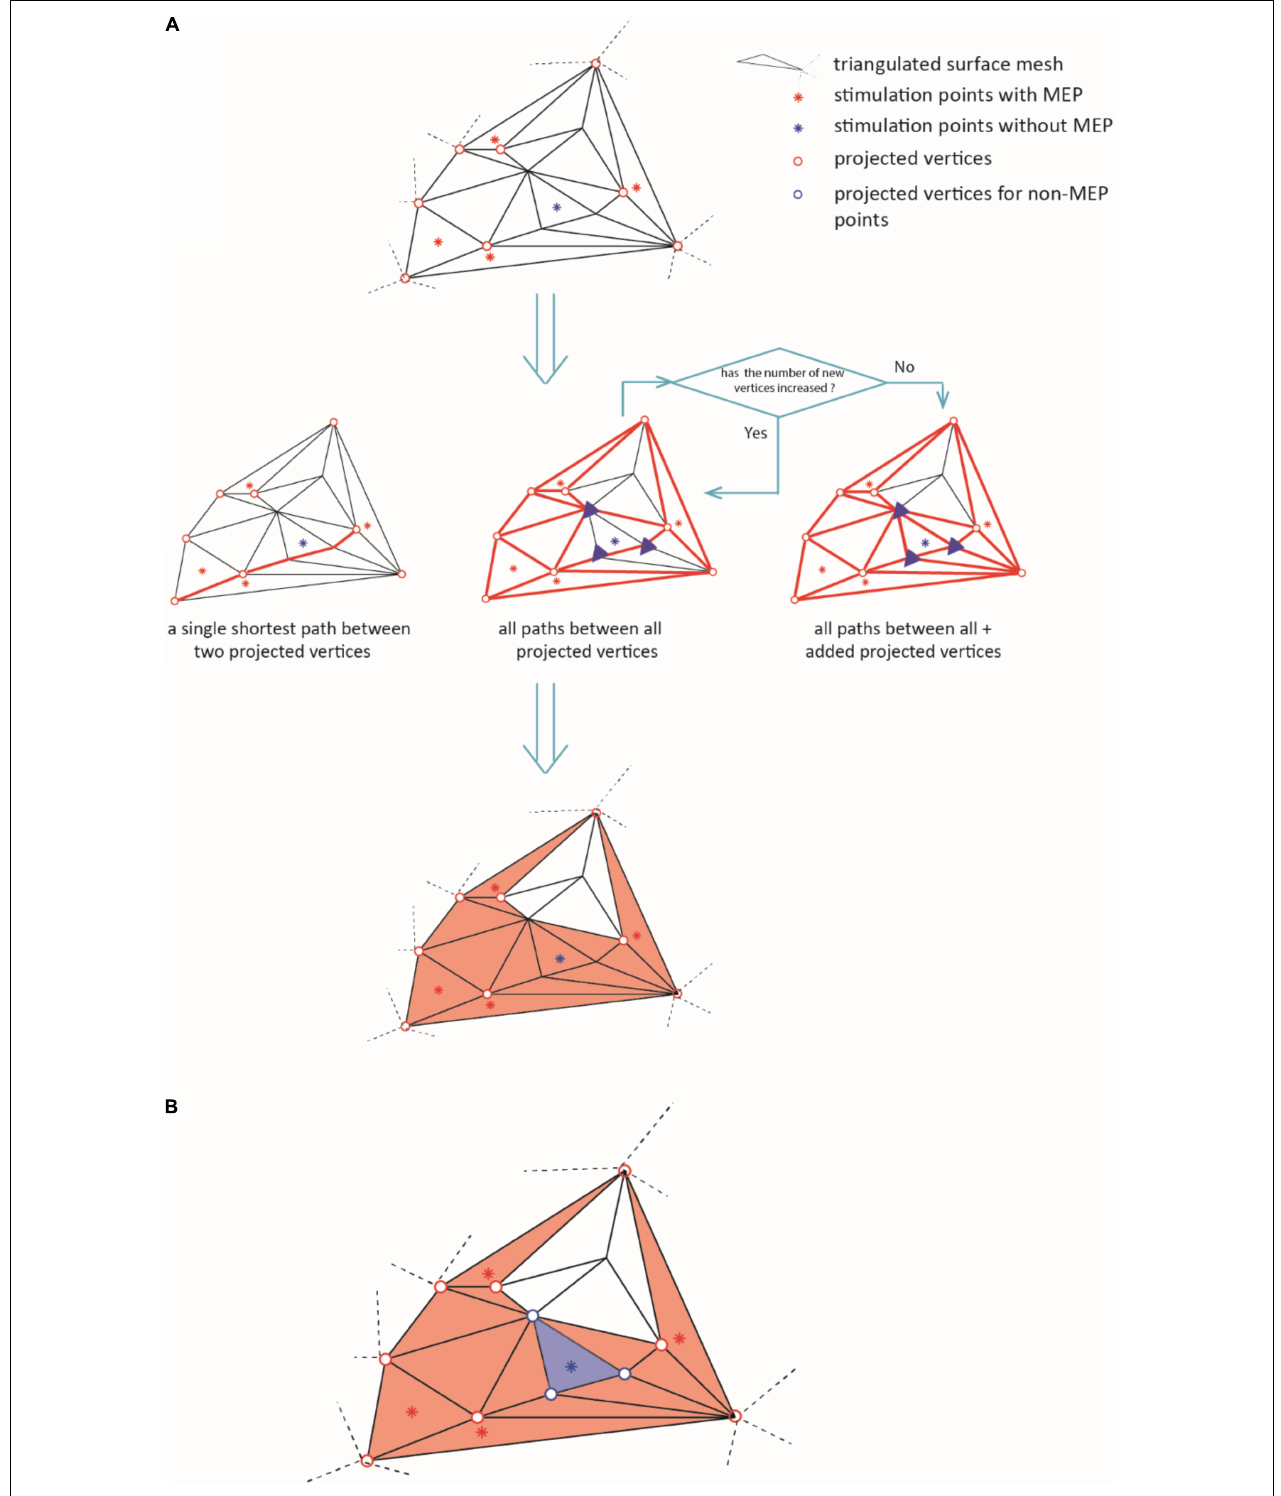
FIGURE 3 | The diagram illustrates the iteration for defining the area of excitability (step iii). In (A) , the red dots represent the active points and the blue dots the non-MEP one. Bold red lines indicate the shortest paths between the active points resulting in the orange shaded active area. (B) Removal of non-MEP points (step iv). The red dots represent the active points and the blue dots the non-MEP one. Bold lines indicate the shortest paths between the active points resulting in the orange shaded active area, and the blue background shows the (to-be-removed) non-active area.